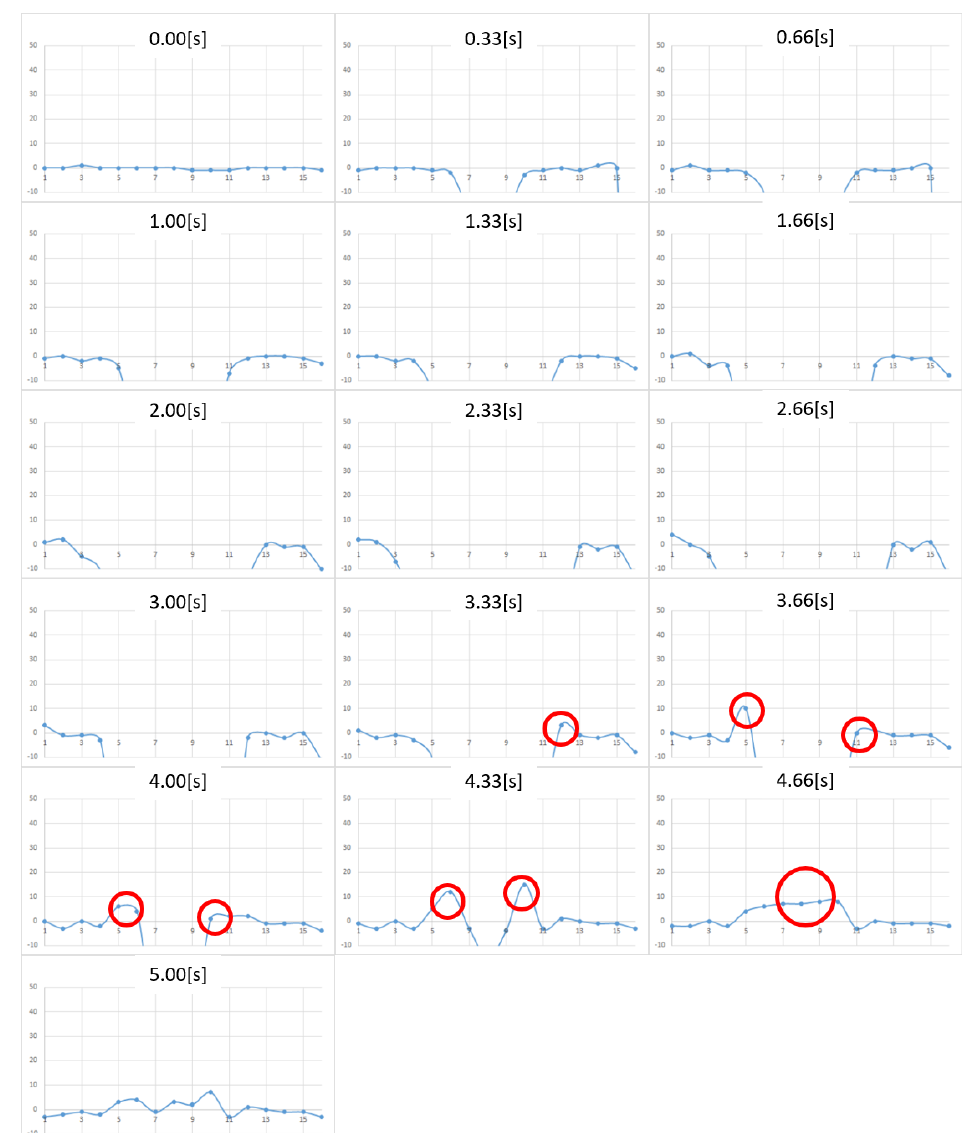
Figure 15. Change in pressure distribution for shampoo. The vertical axis represents the force (in milli newton). The horizontal plane represents the location of the sensing point.